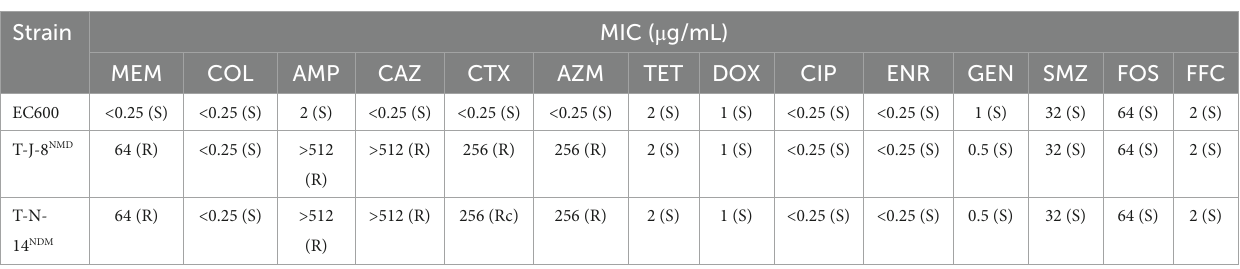
TABLE 2 The MICs for MPECs and